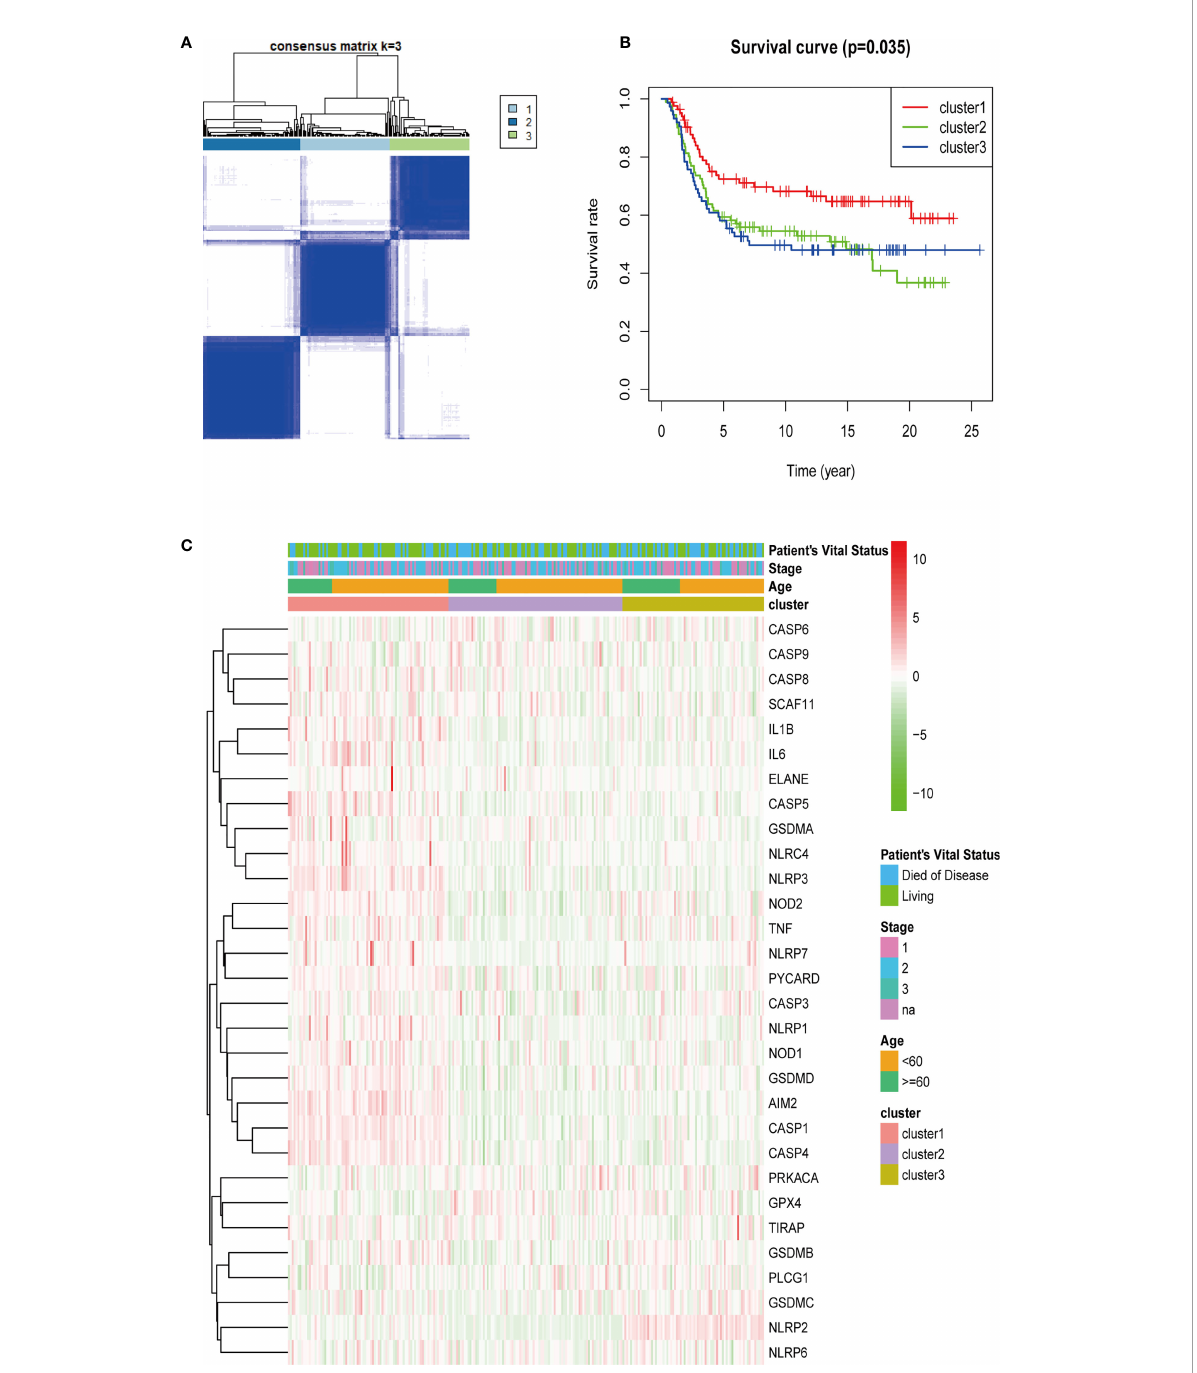
FIGURE 3 Tumor classi fi cation based on pyroptosis-related genes. A total of 249 patients with TNBC were grouped into three clusters according to the consensus clustering matrix (k = 3) (A) . Kaplan – Meier over survival curves for the three clusters (B) . Heatmap and the clinicopathologic characters of the three clusters classi fi ed through these DEGs (C) (stage, AJCC tumor stage